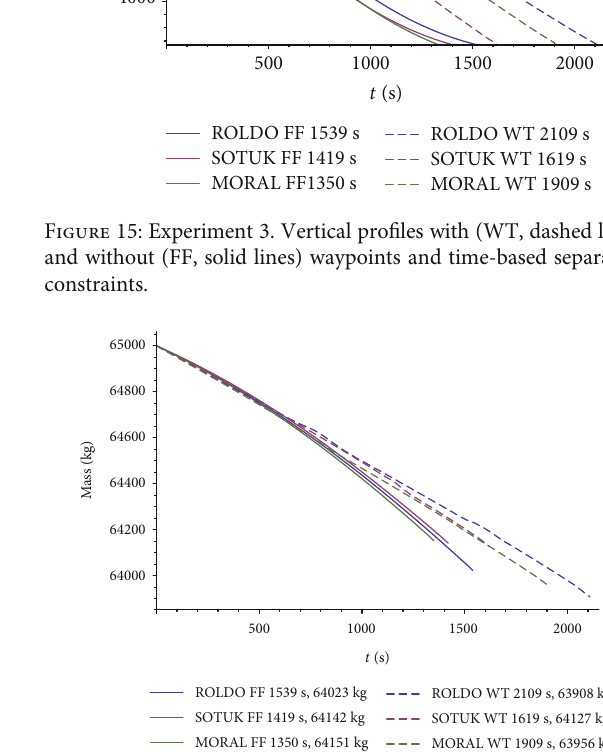
Figure 16: Experiment 3. Mass consumption with (WT, dashed lines) and without (FF, solid lines) waypoints and time-based separation constraints.